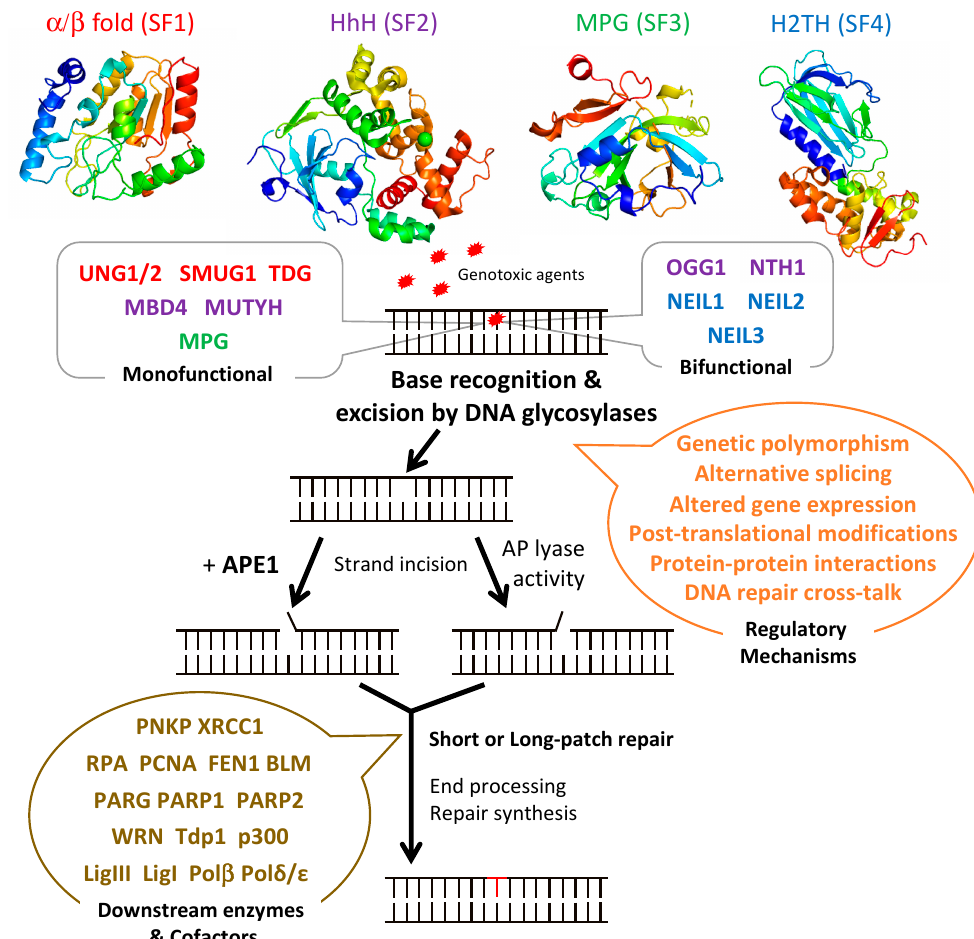
Figure 1. Schematic diagram illustrating the steps and enzymes involved in the base excision repair (BER) pathway. Representative structures of the di ff erent superfamilies (SF) of DNA glycosylases (SF1, α / β fold family, red; SF2, helix-hairpin-helix (HhH) family, purple; SF3, 3-methyl-purine glycosylase (MPG) family, green; SF4, helix-two-turn-helix (H2TH) family, blue) responsible for recognition and removal of damaged bases are shown. After cleavage of the damaged strand by an apurinic / apyrimidinic (AP) endonuclease, APE1, or by the AP lyase activity of bifunctional DNA glycosylases, downstream BER enzymes together with several cofactors (listed in brown) prepare the damaged site for de novo synthesis using one of two sub-pathways: short-patch or long-patch repair. DNA glycosylases are tightly regulated at the gene, mRNA, and protein levels by a set of regulatory systems (listed in orange). UNG1 / 2: uracil-N glycosylase 1 or 2; SMUG1: single-strand-specific monofunctional uracil DNA glycosylase 1; TDG: thymine DNA glycosylase; MBD4: methyl-CpG-binding protein 4; MUTYH: MutY homolog DNA glycosylase; OGG1: 8-oxo-G DNA glycosylase 1; NTH1: endonuclease III-like 1; NEIL1-3: endonuclease VIII-like